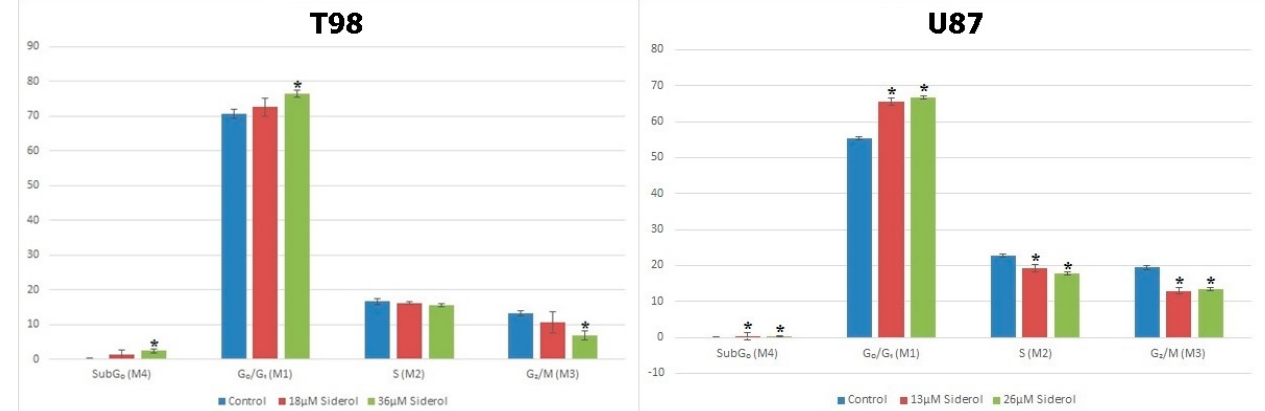
Figure 5. Histogram representation of cell-cycle distribution in T98 ( a ) and U87 ( b ) cell lines after treatment with siderol in concentrations of IC50 and twice IC50 values.